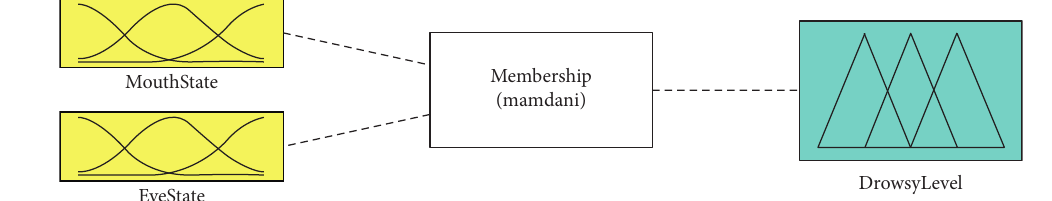
Figure 9: FIS editor showing the main simulation screen for driver drowsy.